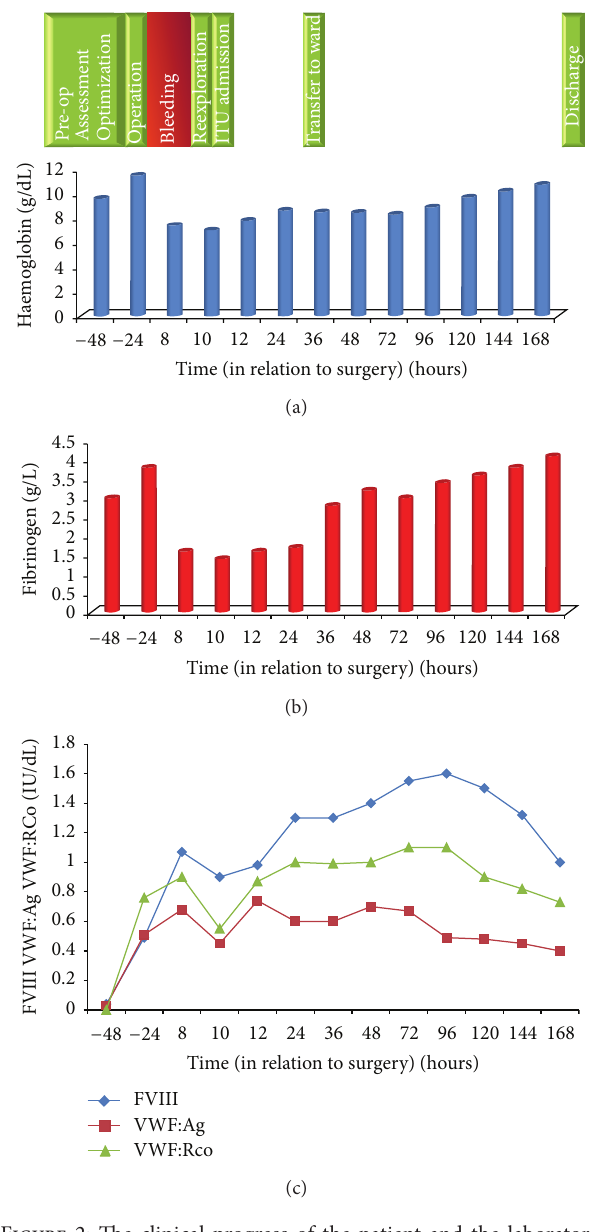
Figure 2: The clinical progress of the patient and the laboratory parameters throughout (time in hours in relation to surgery). The laboratory parameters include (a) haemoglobin g/dL, (b) fibrinogen g/L, and (c) factor assays for FVIII, VWF:Ag, and RCo in IU/dL.